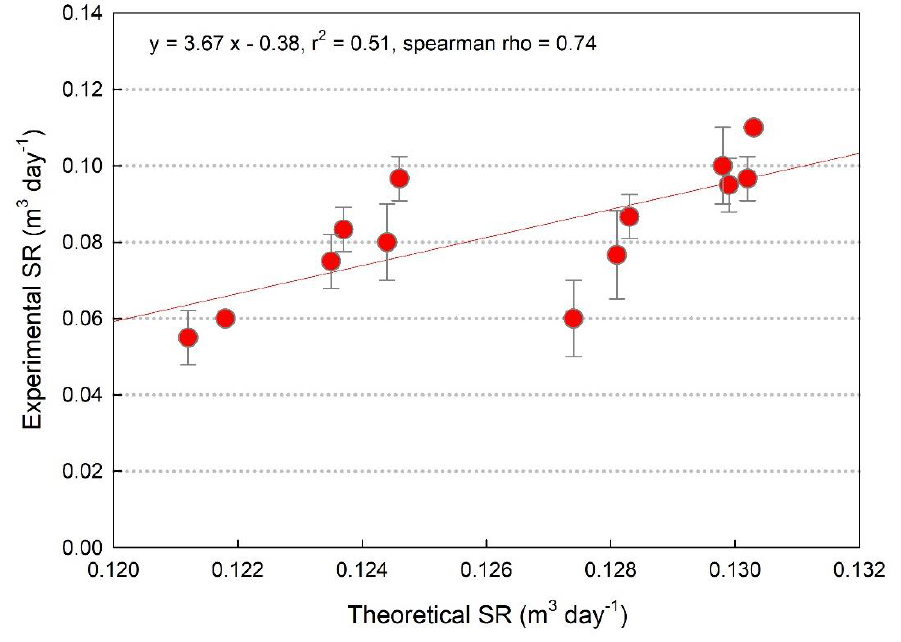
Figure 7. Comparison between the theoretical and experimental SRs in this study.